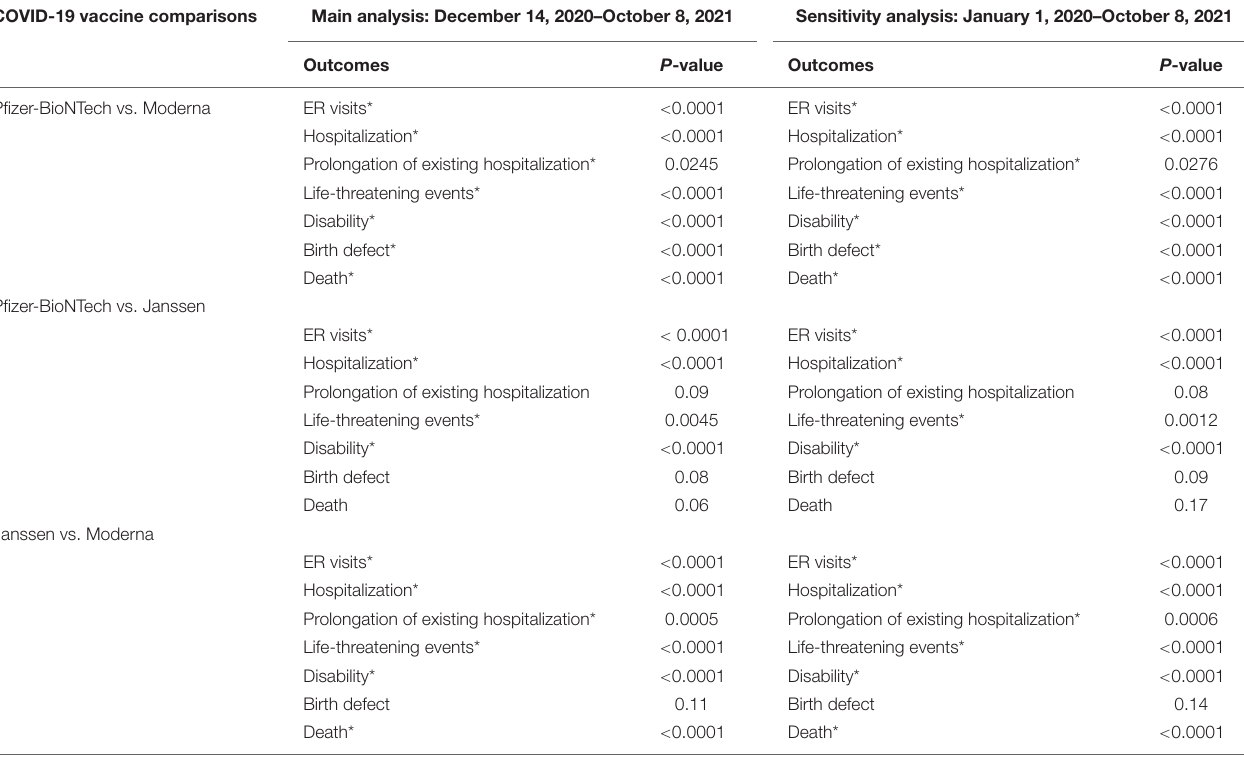
TABLE 5 | Breslow-day tests for paired comparisons between individual COVID-19 vaccines. COVID-19 vaccine